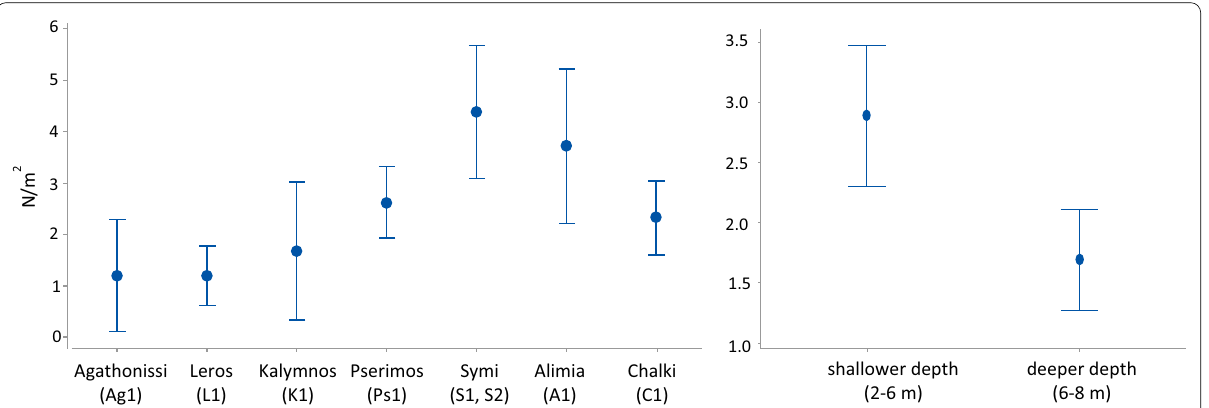
Fig. 2 Mean population density Fisher LSD of Diadema setosum in the densely populated (A, C or F relative abundance grade) islands (left) and in ± the two depth zones (right) surveyed